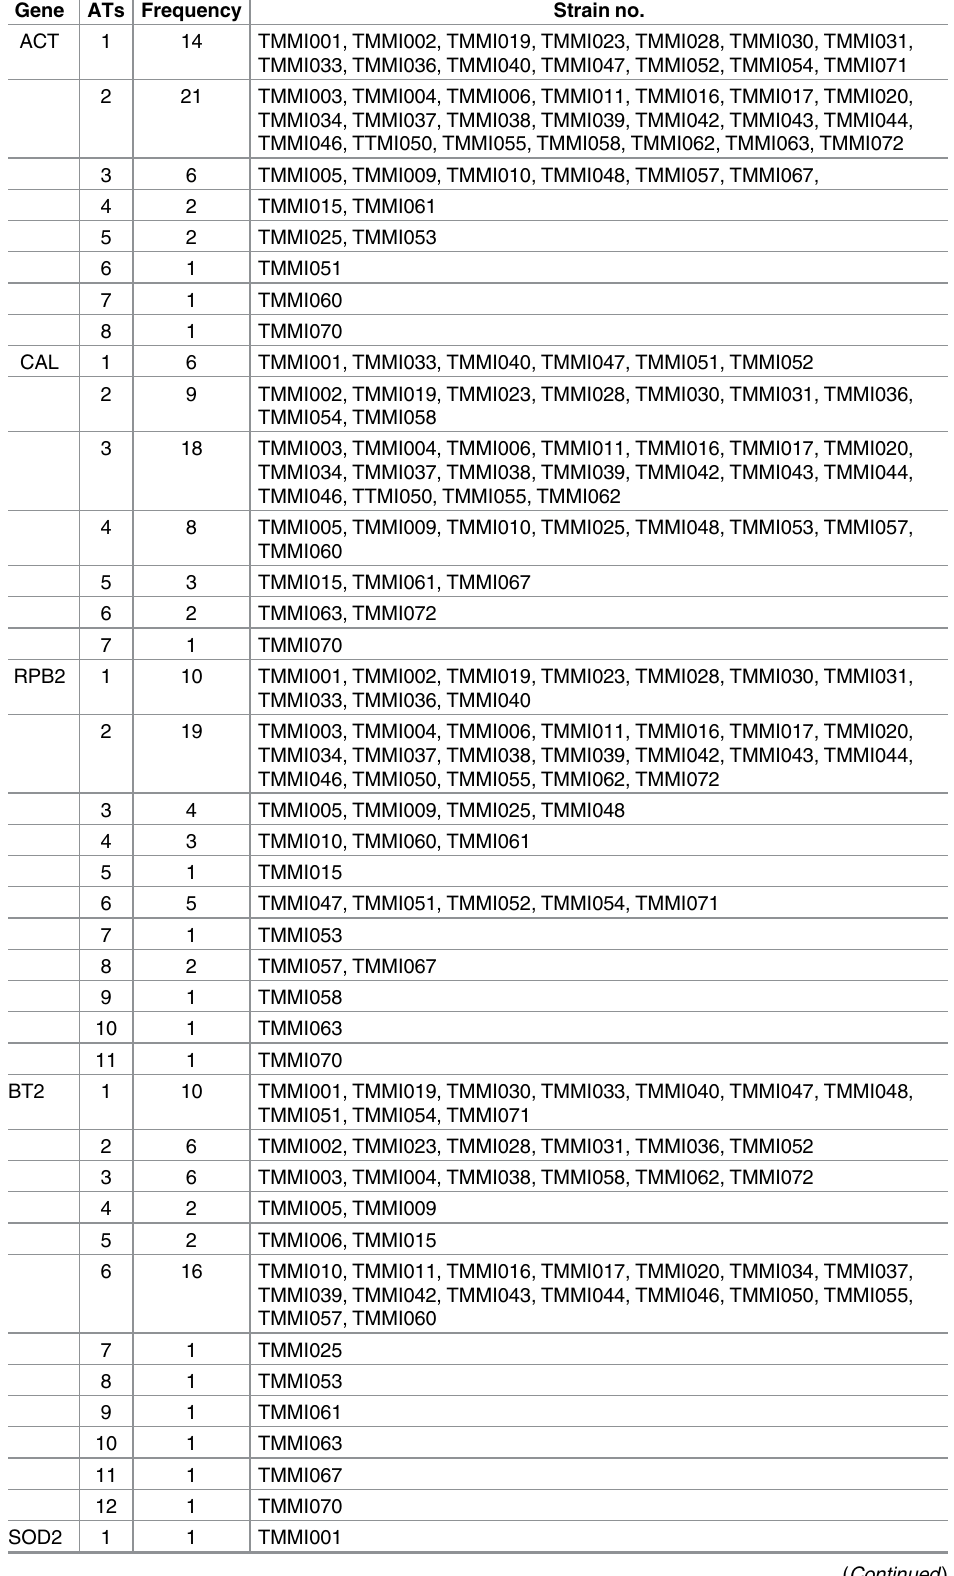
Table 5. Allele types number and frequency. Gene ATs Frequency Strain